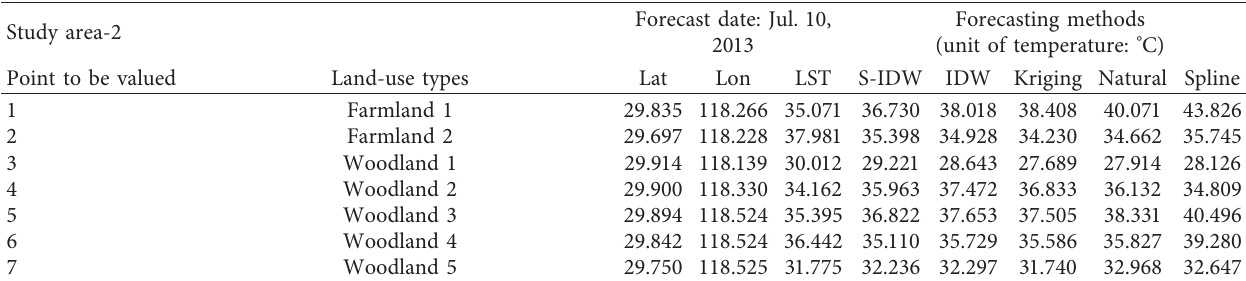
∗ Significant correlation at 0.05 level (two-tailed). Table 18: Comparison of interpolation results of 5 kinds of interpolation methods on Jul. 10,